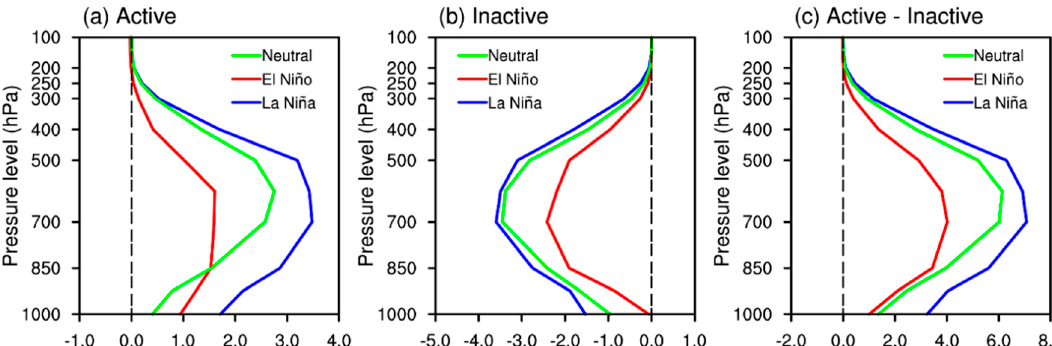
Figure 9. Composite vertical profiles of region-averaged filtered specific humidity anomaly (unit: 10 − 1 g·kg − 1 ) during the ( a ) active and ( b ) inactive MJO phases; ( c ) differences between phases in neutral years (green), the El Niño years (red), and the La Niña years (blue) over the SCS during June–November over the period of 1979–2016. The definition of the active and inactive phases for the MJO-related SCS TC genesis under different ENSO conditions is in Table 1.